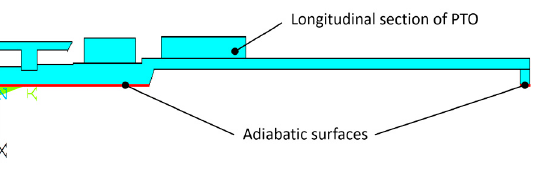
Figure 10. Two-dimensional axially symmetric structure of the PTO considered for FEM analysis.